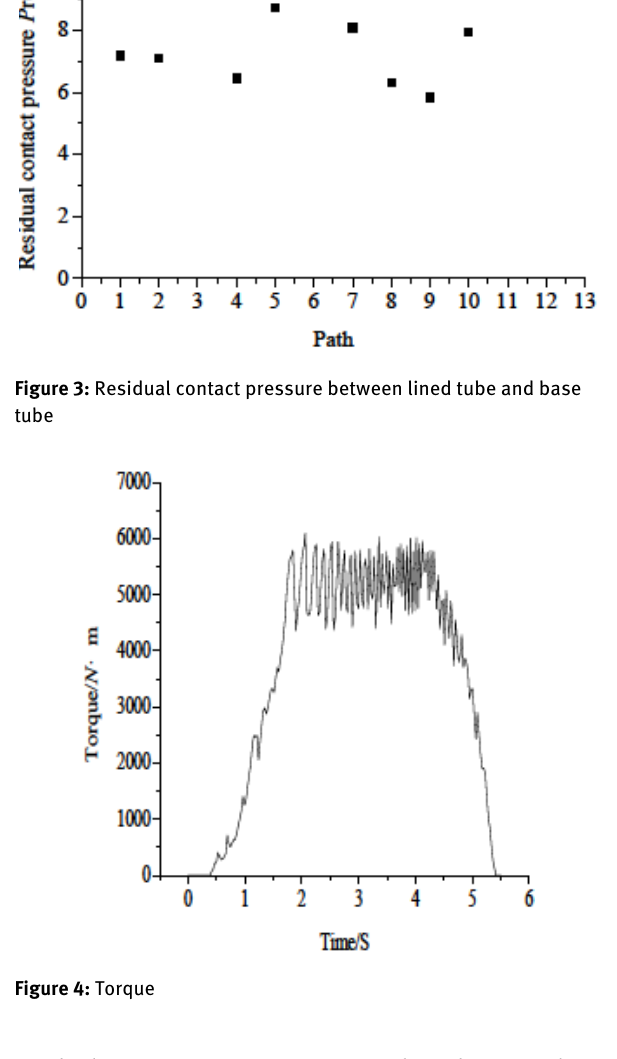
residual contact pressure. In practical production, physi- cal defects, such as small concave anti-bulge on inner wall of base tube or outer wall of liner, would also lead to un- even distribution of contact pressure between liner and base